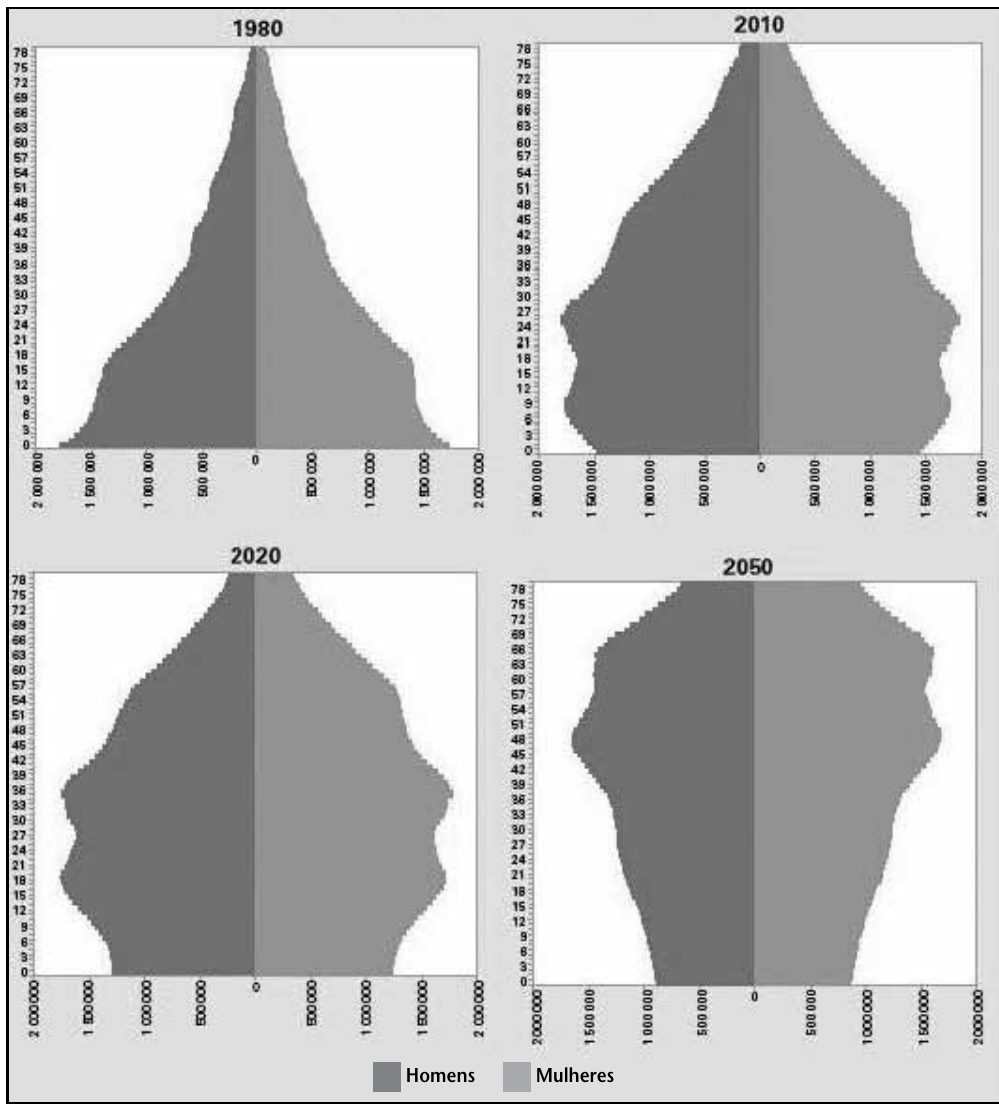
Figura 1 – Composição absoluta da população por idade e sexo (Brasil)